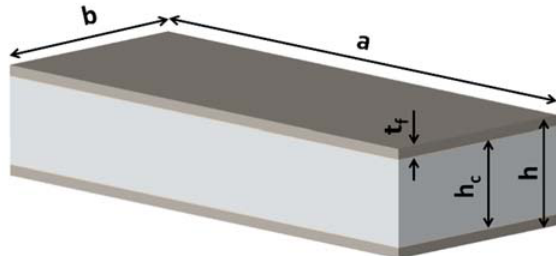
Figure 2. Honeycomb panel geometrical descriptors.